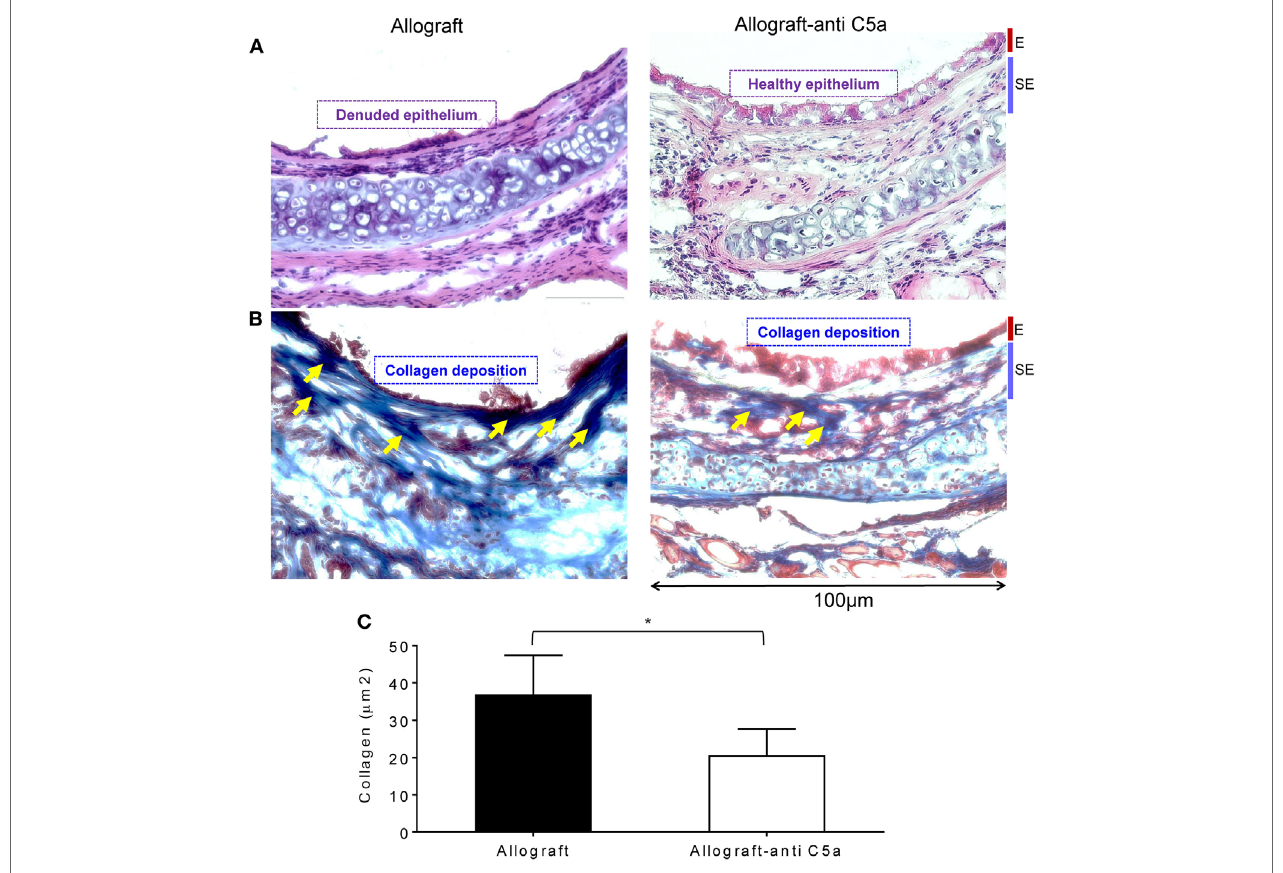
FigUre 5 | C5a inhibition improves allograft health and prevents collagen deposition. (a) H&E staining of BALB/c → C57BL/6 allotransplants on d28 posttransplantation. (B,c) Subepithelial deposition and quantification of collagen: blue bands represent subepithelial collagen deposition and quantification of collagen blue bands was performed using ImageJ program. “E” and “SE” designate graft epithelial and subepithelial areas, respectively. Data are shown as means with SE and representative images of at least two different experiments ( n = 3–4). *p < 0.05. Original magnification, ×